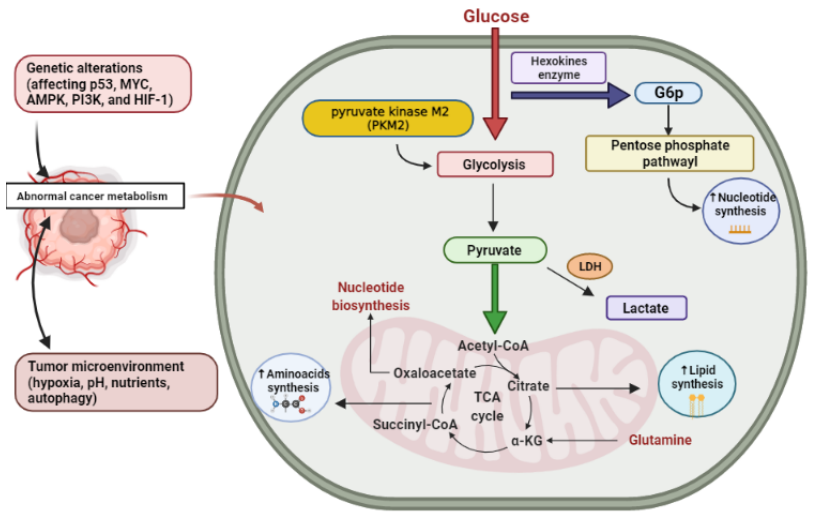
Figure 1. Cancer altered metabolism. G6P, glucose-6-phosphate; LDH, lactate dehydrogenase enzyme; α -KG, alpha-ketoglutarate. Created using Biorender